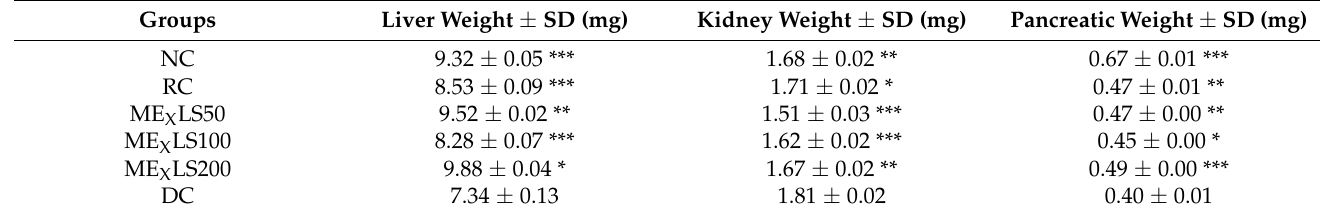
Table 3. Effect of ME X LS on liver, kidney, and pancreas weights in intervention period.